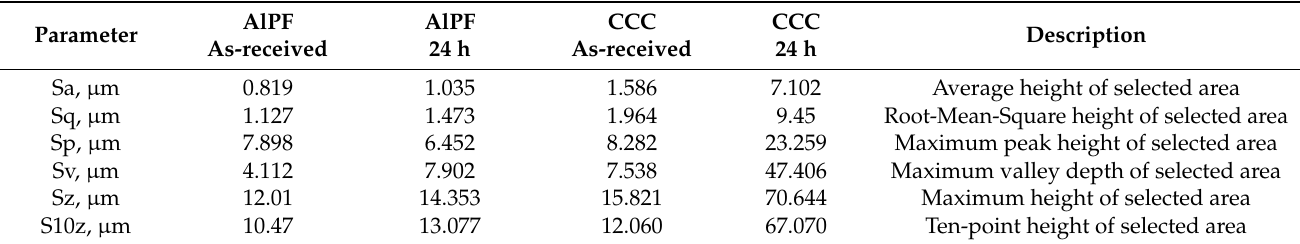
Figure 9. Optical profilometry micrographs and surface roughness parameters of the CCC ( a , b ) and AlPF PEO ( c , d ) coatings, including three-dimensional (3D)-rendered images and two-dimensional (2D) topographical maps and corresponding calculated surface parameters. Table 3. Surface texture parameters of CCC and AlPF coatings before and after immersion in 0.5 wt.% NaCl for 24 h and EIS